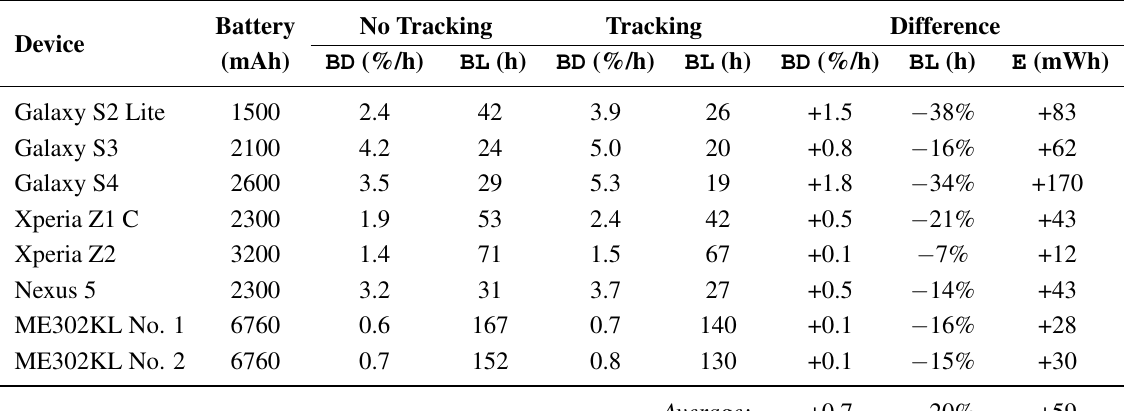
Table 4. Impact of BX Tracker on battery consumption, as measured on various mobile devices. BD : average battery drain per hour; BL : estimated battery lifetime on a full charge; E : estimated energy